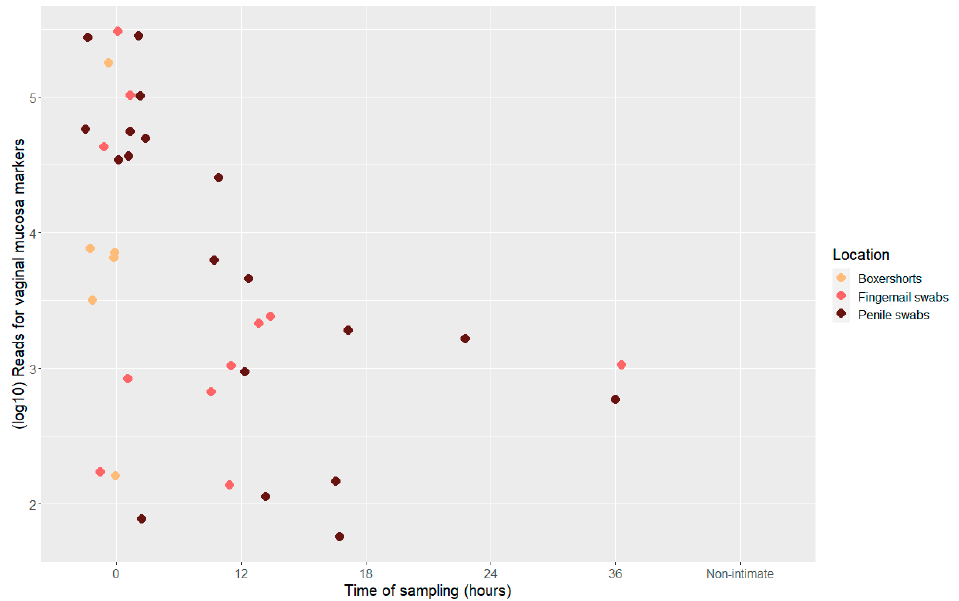
Figure 3. Scatter plot displaying total number of reads (log10) for vaginal mucosa markers, divided into location and time point of sample collection, n = 36.